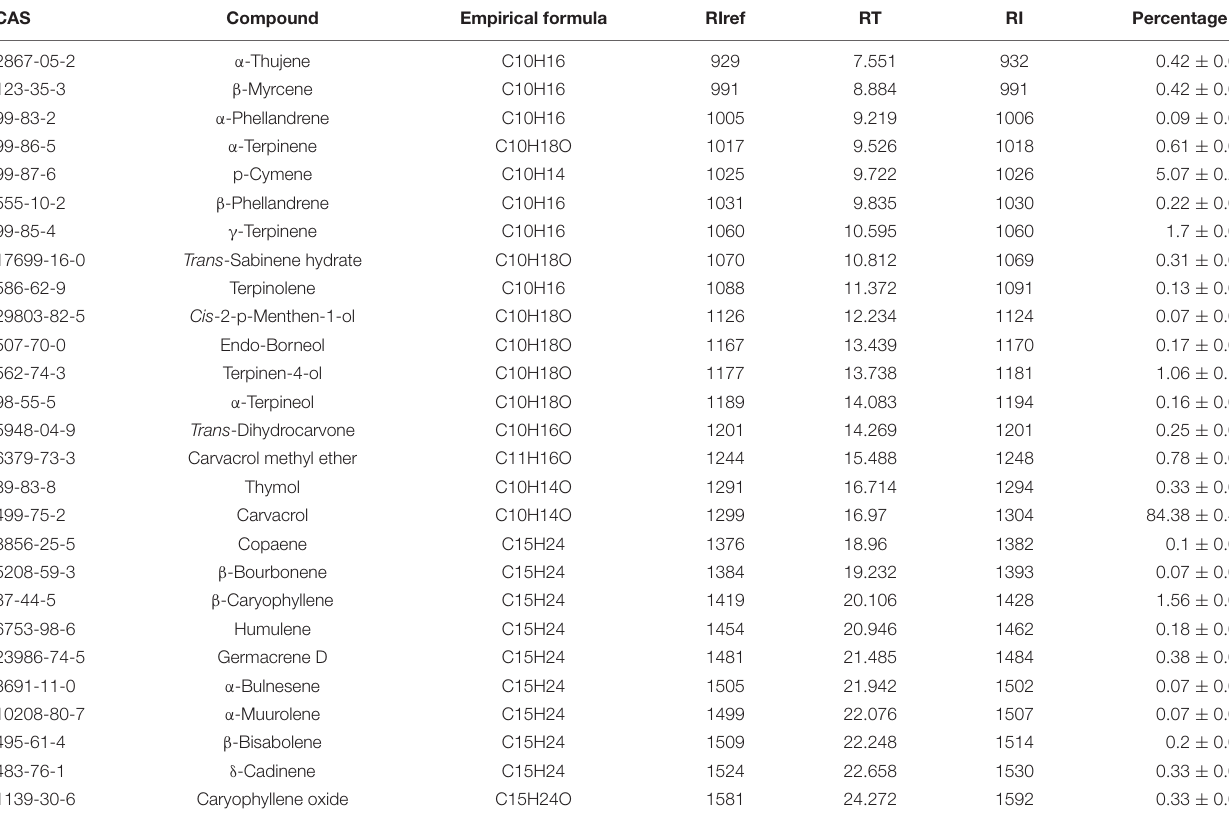
TABLE 1 | Chemical composition (%) of